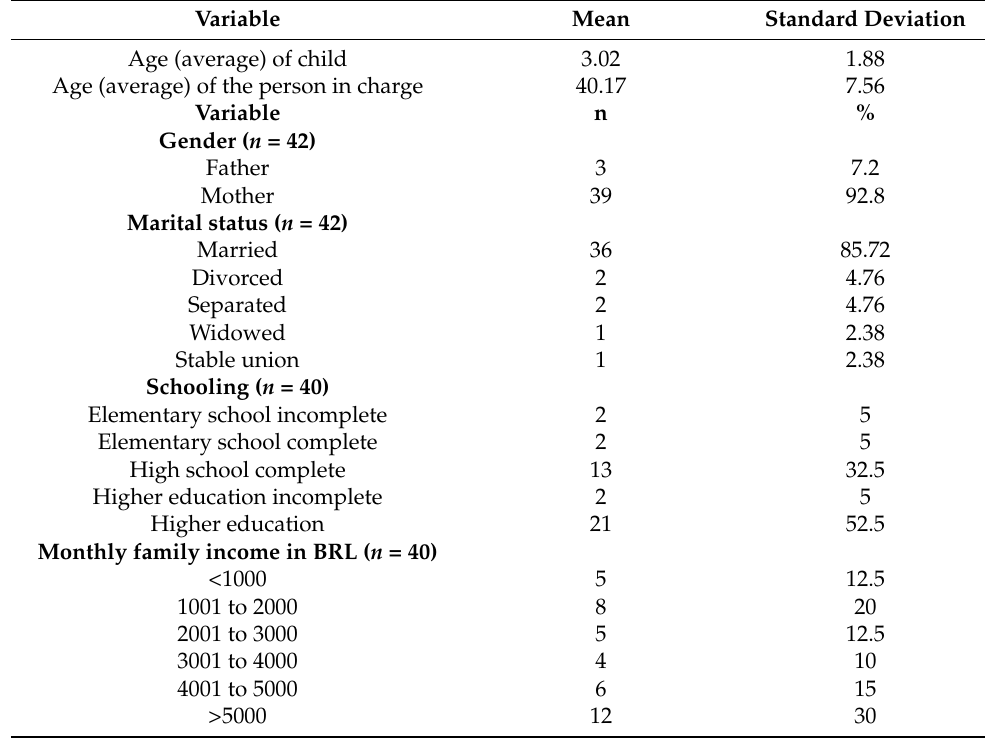
Table 2. Characterization of parents and children with DS, in Belo Horizonte City, Minas Gerais State, Brazil, 2021. Variable Mean Standard